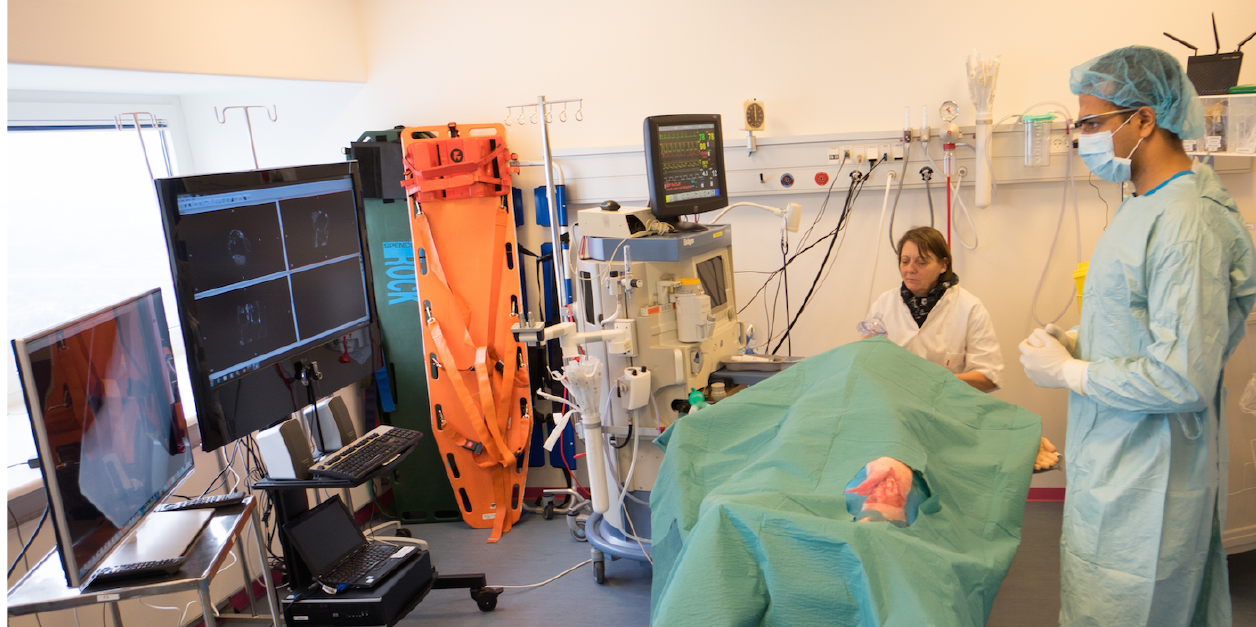
Figure 4. A surgeon (right) uses the Google Glass-based WPA prototype for touch-less interaction with X-rays and MRIs shown on the big display (left) without the need to involve the nurse (in the background) which otherwise typically would be